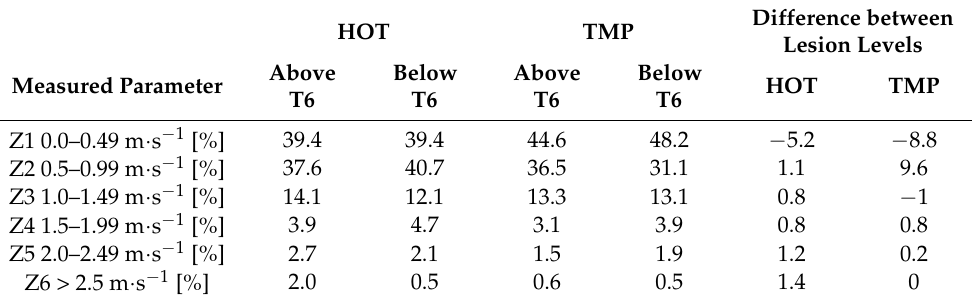
Table 5. Comparison of time spent in different speed zones of players with a lesion level above and below T6. HOT